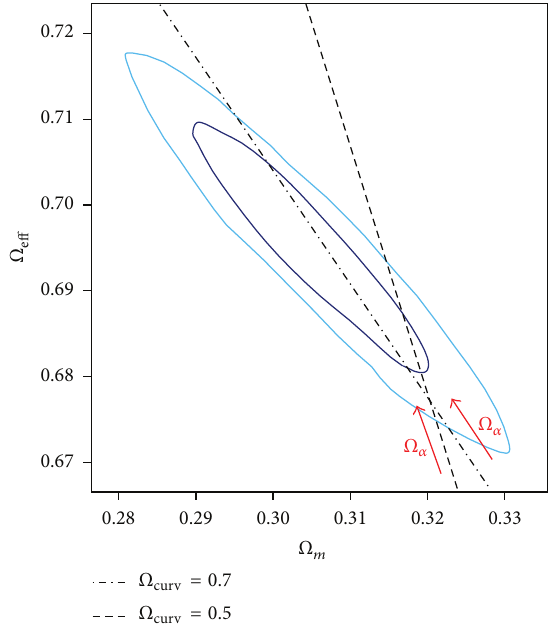
Figure 9: Ω versus Ω 𝑚 in the background of Planck + WMAP + eff high L+ lensing + BAO joint